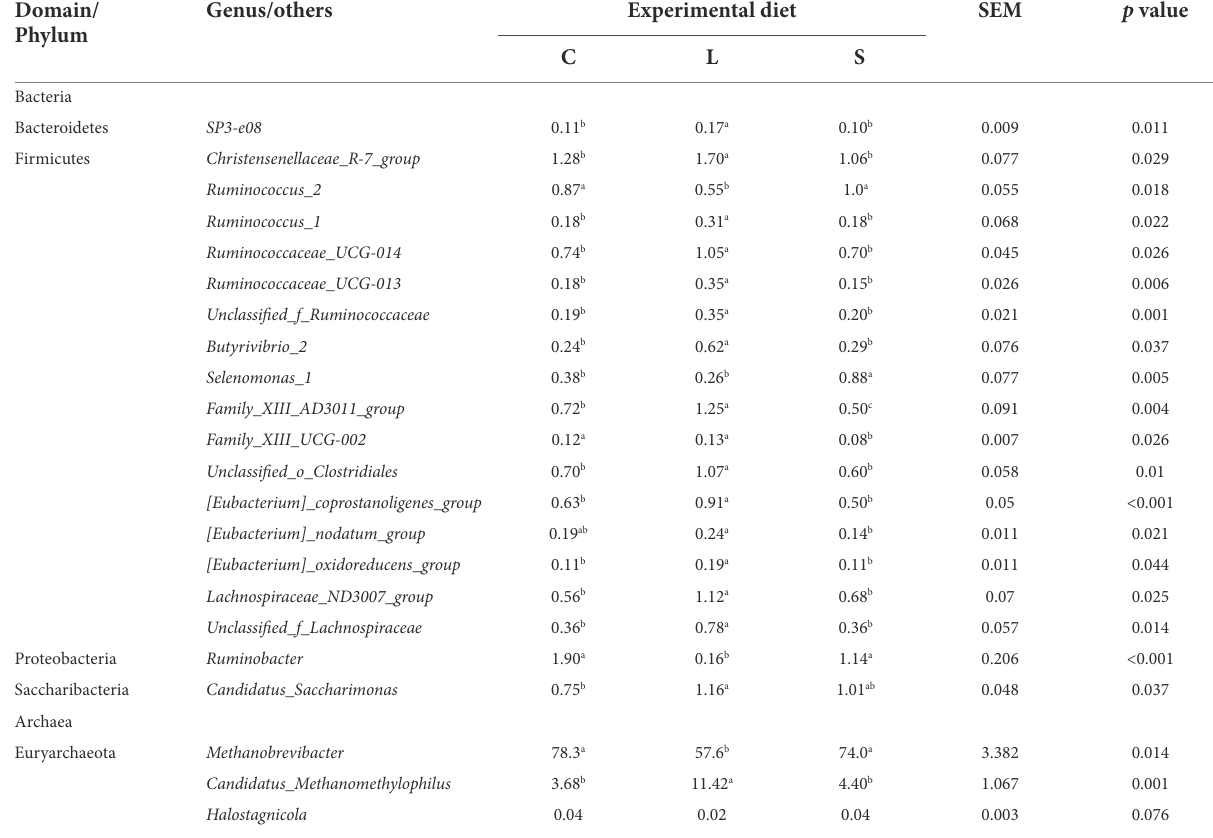
TABLE 5 Effect of two glucogenic (C, S) and a lipogenic (L) diet on the relative abundance (%) of the top 20 affected bacteria and the top three differential archaea at the genus level after 48 h in vitro fermentation with rumen fluid of dairy cows. Domain/